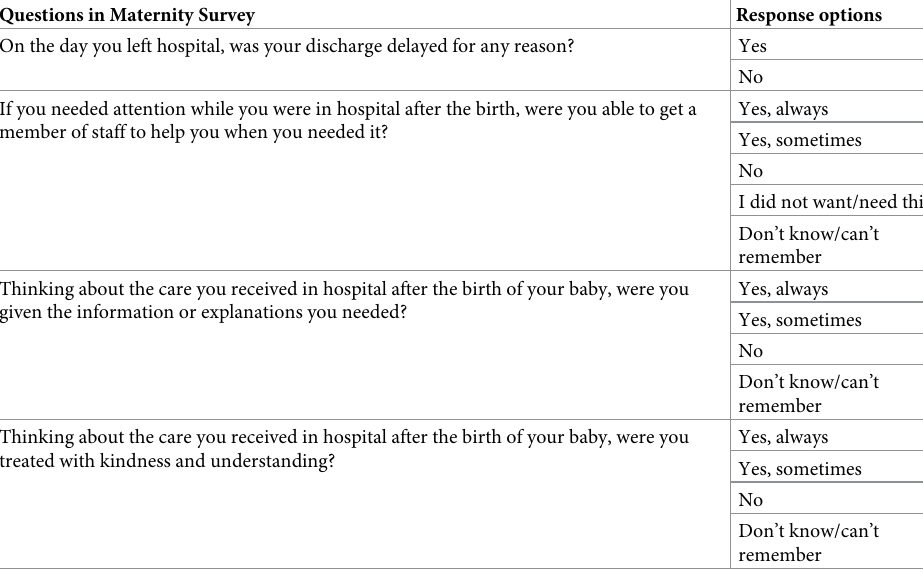
Table 1. Questions in maternity survey selected for analysis in this